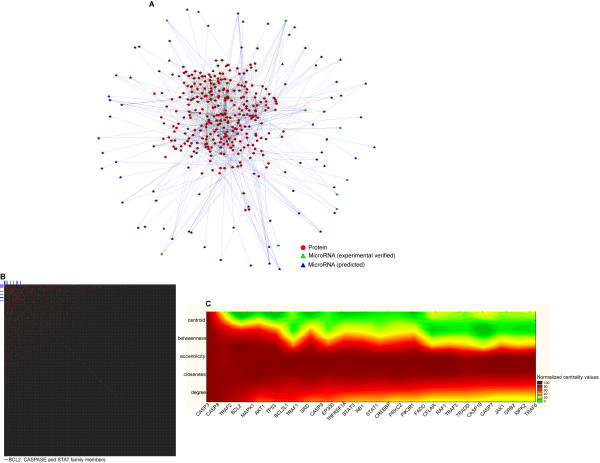
Interactomics of AM. Panel A. AM Network: red circles represent the proteins; green triangles represent experimentally verified microRNAs; blue triangles represent predicted microRNAs; blue lines represent the interactions (protein-protein, protein-DNA, microRNA-mRNA interactions). Panel B. Matrix of interactions of AM. Each axis represents all AM proteins and the red dots indicate the presence of an interaction of a given pair of proteins. The blue lines point out the BCL2, CASPASE and STAT family members. Panel C. Heat map of centrality values of AM proteins: the X-axis represents the AM proteins with the highest centrality, while the Y-axis represents different centrality parameters (betweenness, centroid, closeness, degree, eccentricity). The colours indicate the centrality levels, according to the colour bar shown on the right of the matrix.